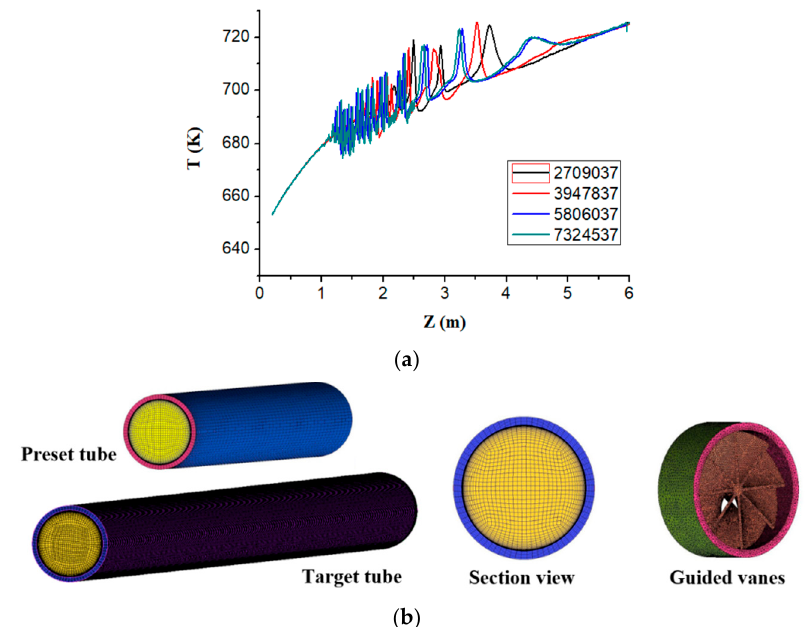
Figure 5. Generation and test of the numerical grid: ( a ) temperature on Line 1 with different grids; ( b ) schematic diagram of the grid.